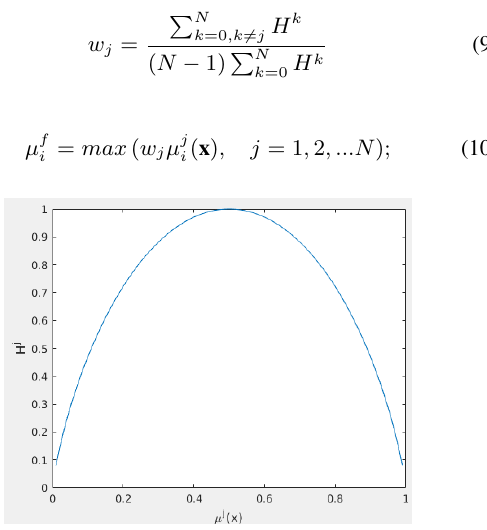
Figure 5. Entropy curve of 2 -class